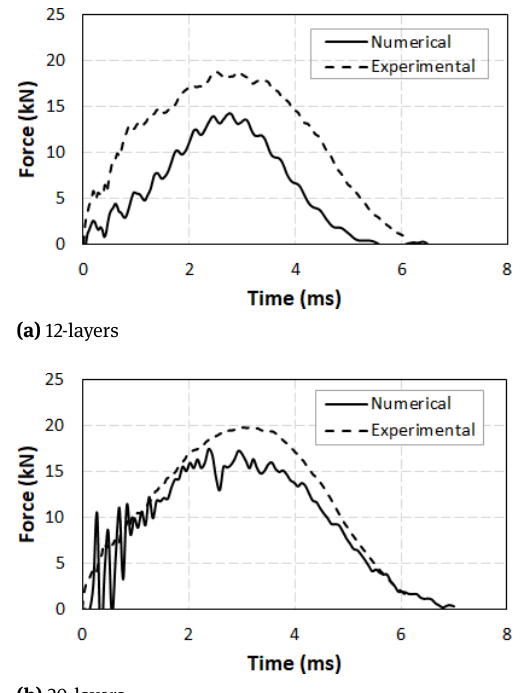
Figure 5: Experimental and numerical force-time histories of UHMWPE Reinforced